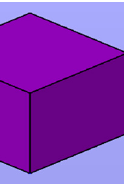
Figure 2. A cube model (10 × 10 × 10 mm 3 ). Table 1. Comparison of different CAD file formats